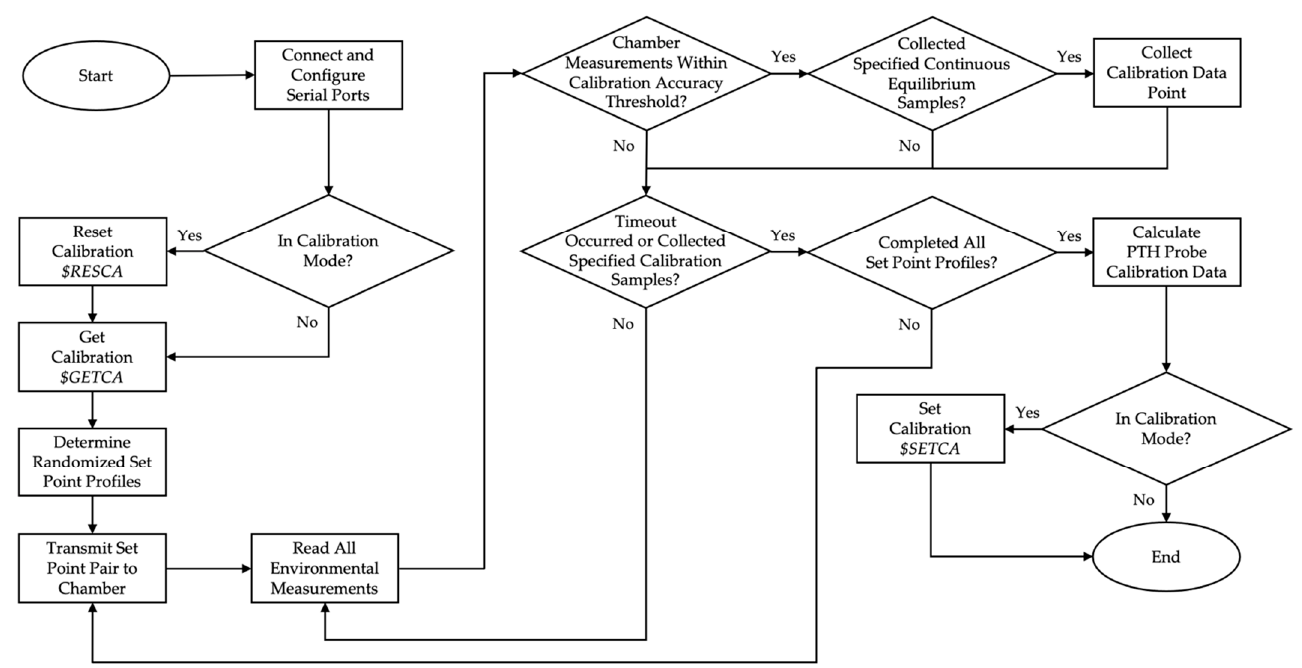
Figure 6. Block diagram of the automated calibration system generalizing functionality.